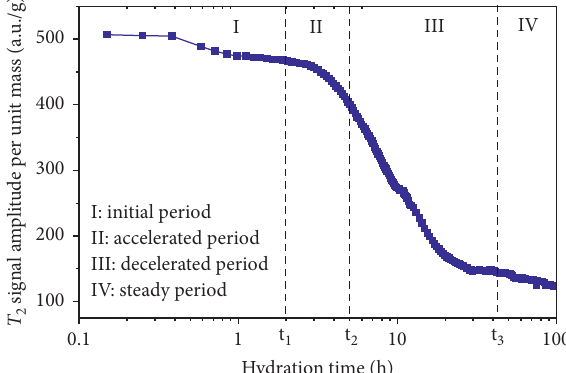
Figure 2: The first peak amplitude A( t ) in unit mass changes with time.